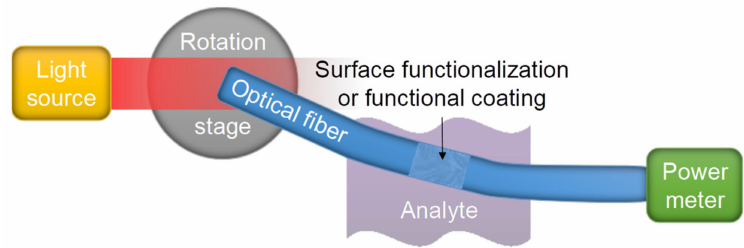
Figure 3. Illustration of the experimental setup of a typical skew-ray-based optical